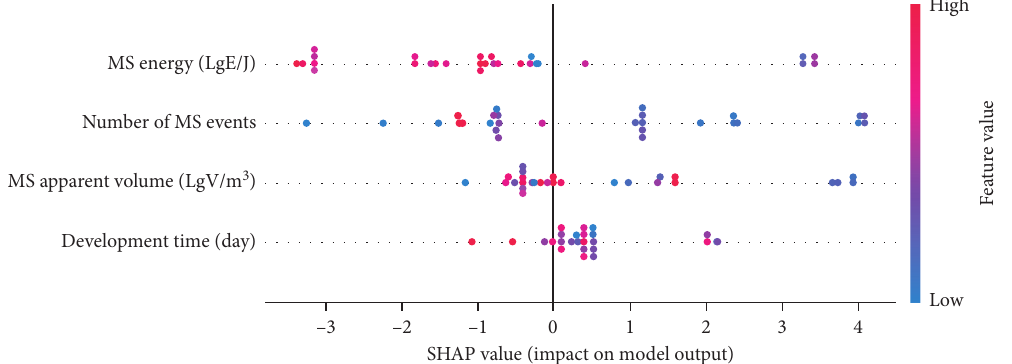
Figure 6: Impact on rockburst of different microseismic parameters based on SHAP.